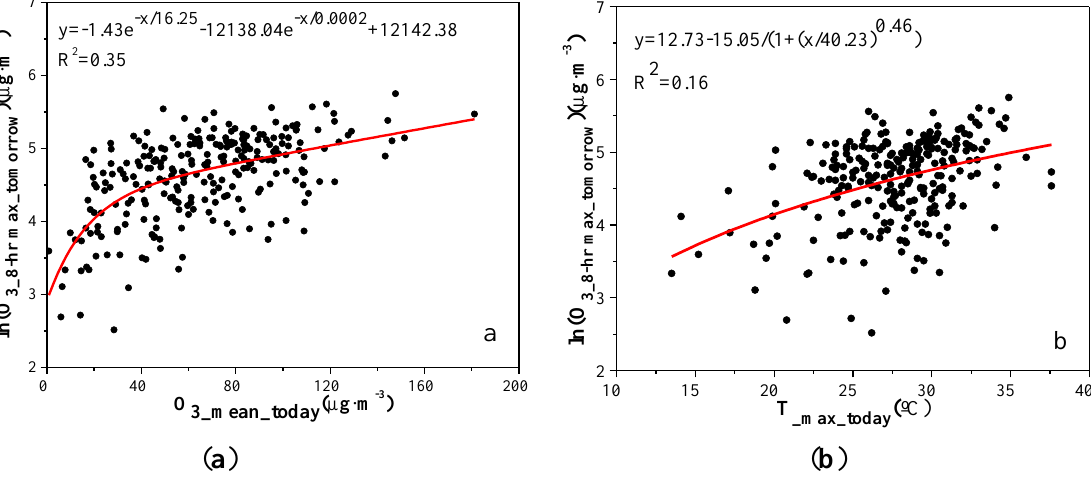
Figure 7. The changes of O at the following day in the response to ( a ) ozone 3_8-hr max concentration; ( b ) temperature on the first day during the study